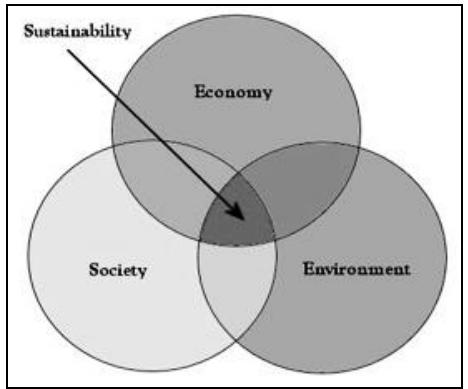
Figure 1. Three main aspects of sustainability (from Juneau Commission on Sustainability)